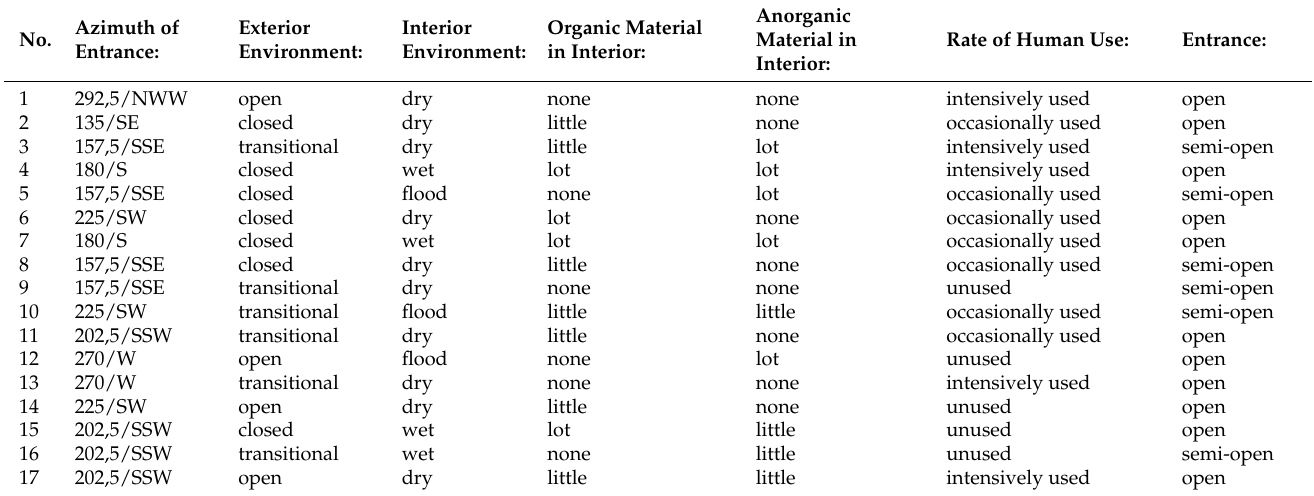
Table A3. Table of SA-CEFs study objects with data that were obtained by field survey (2014-2021). The numbering of the individual SA-CEFs corresponds to the data in Table 1—part 1.